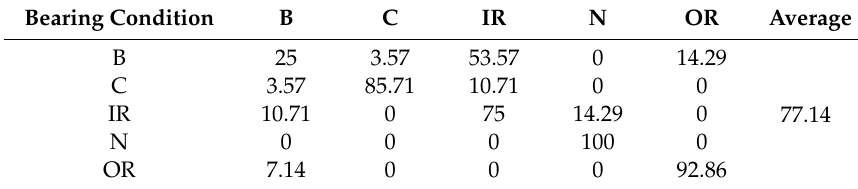
Table 10. Classification accuracy of SVM